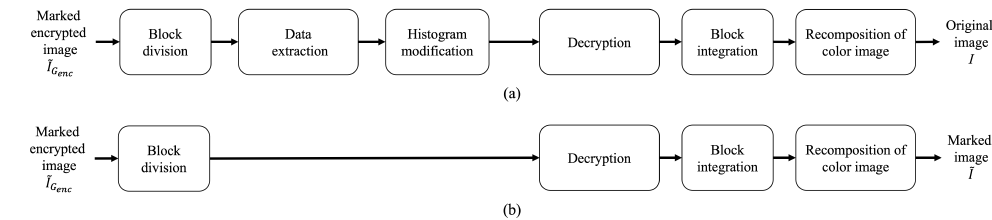
Figure 7. Options for restoration in proposed method. ( a ) Data extraction and decryption;( b ) decryp- tion without data